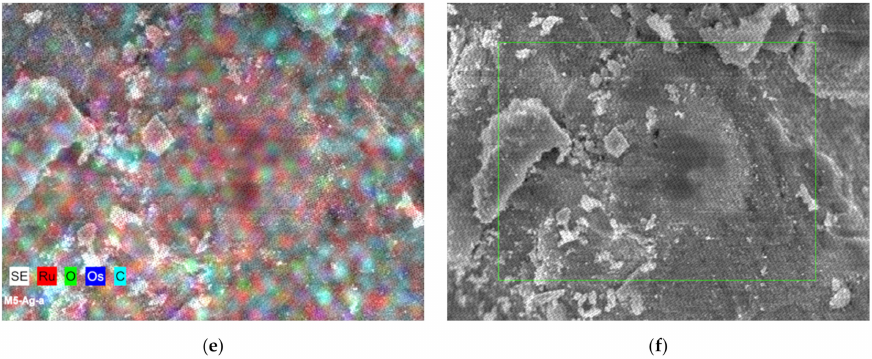
Figure 1. Individual elemental distribution mappings of ( a ) Ru, ( b ) Os, ( c ) C, ( d ) O, and ( e ) overlay of a ( f ) selected area in the OsRu material.